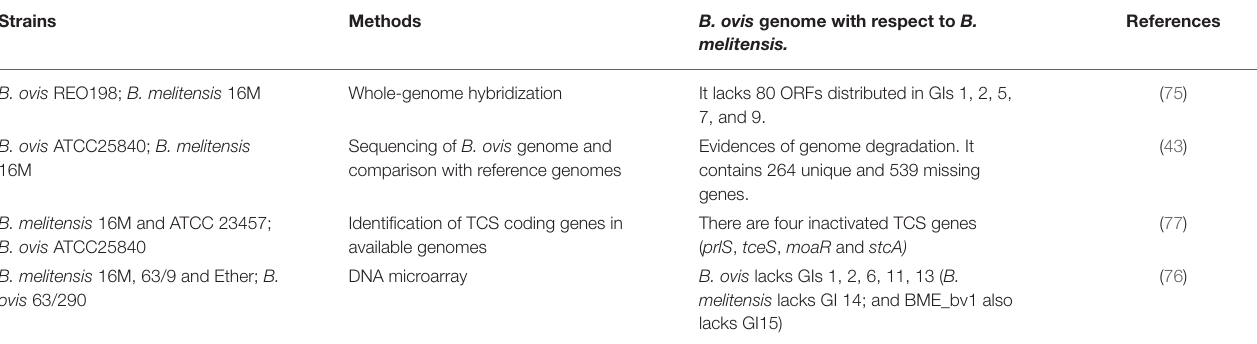
TABLE 2 | Comparative genetic studies including B. melitensis and B. ovis